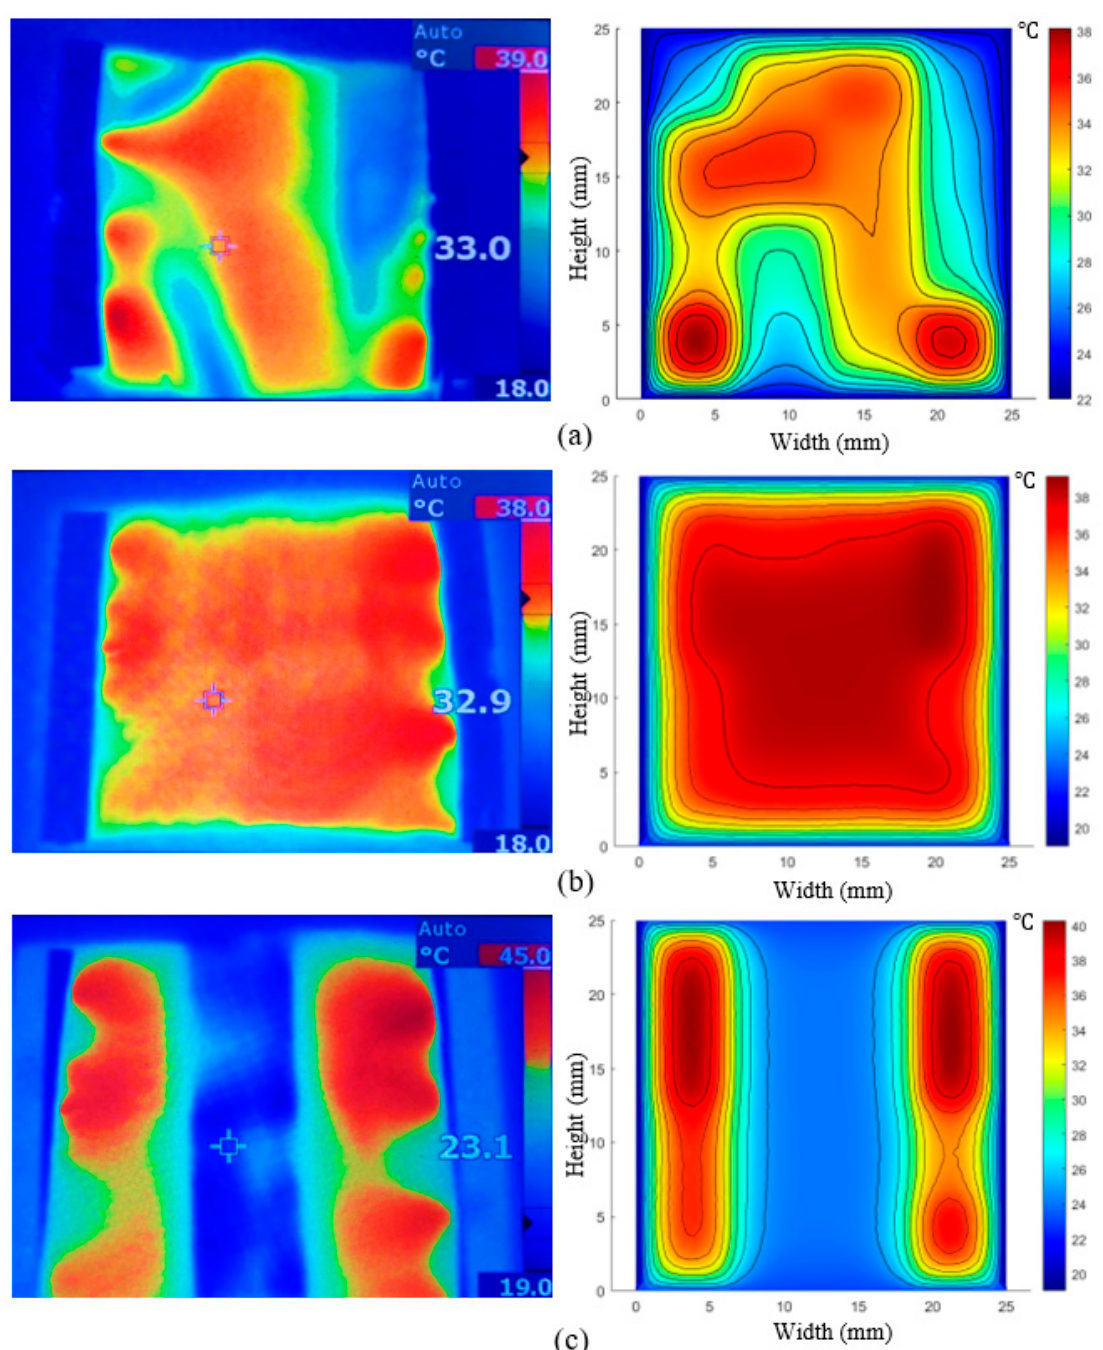
Figure 9. ( a ) Heated sample without insulation: thermal image (left) simulation (right), ( b ) heated sample insulated with neoprene; thermal image (left) simulation (right), ( c ) heated sample with a small strip of copper placed underneath the sample: thermal image (left) simulation (right).